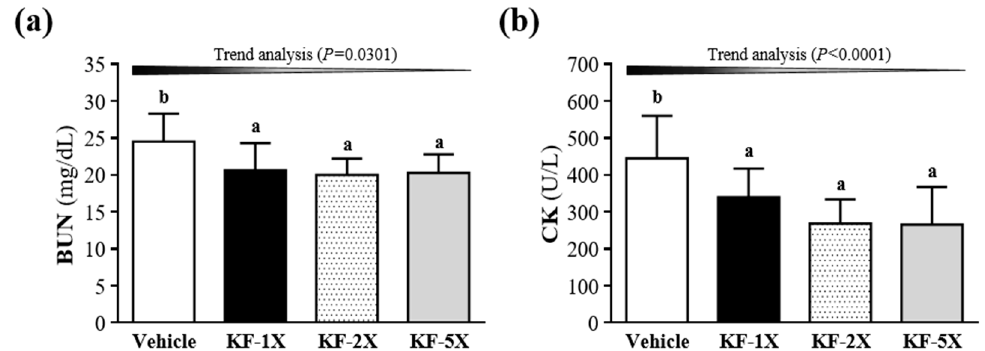
Figure 4. Effects of kefir (KF) supplementation on the serum levels of ( a ) blood urea nitrogen (BUN) and ( b ) creatine kinase (CK) after a 90-min swimming test and a 60-min resting period. Data are